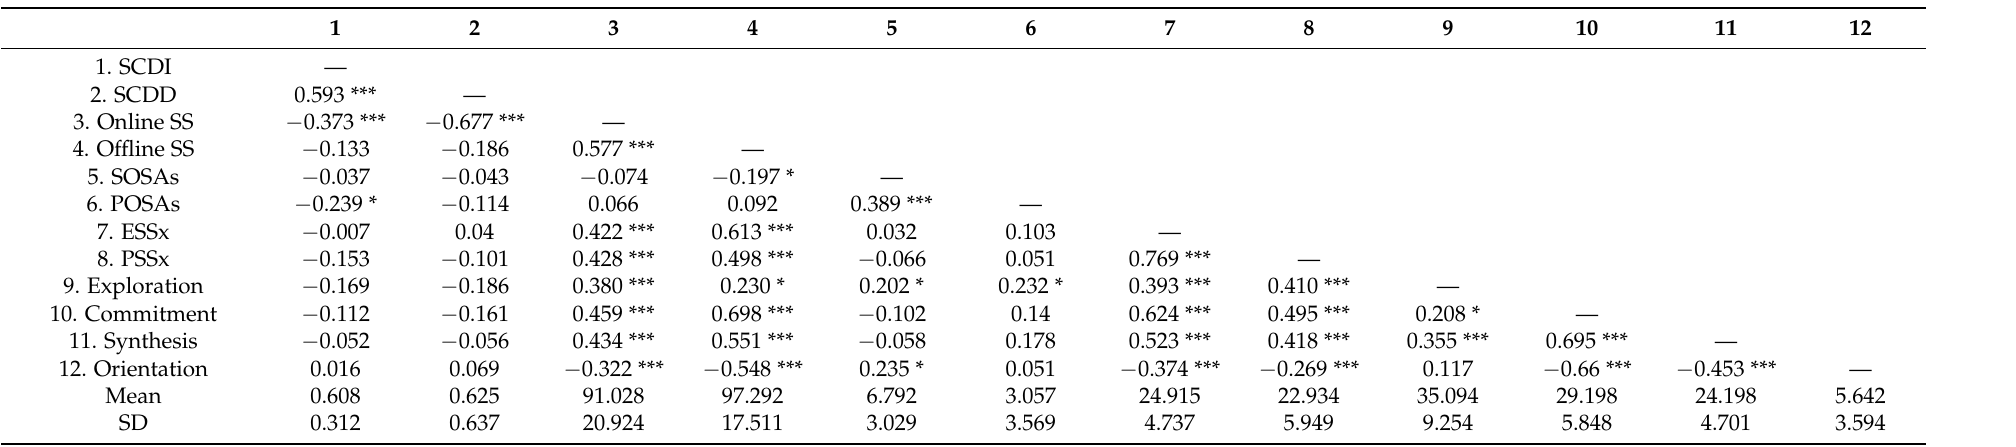
Table 1. Correlation matrix and descriptive